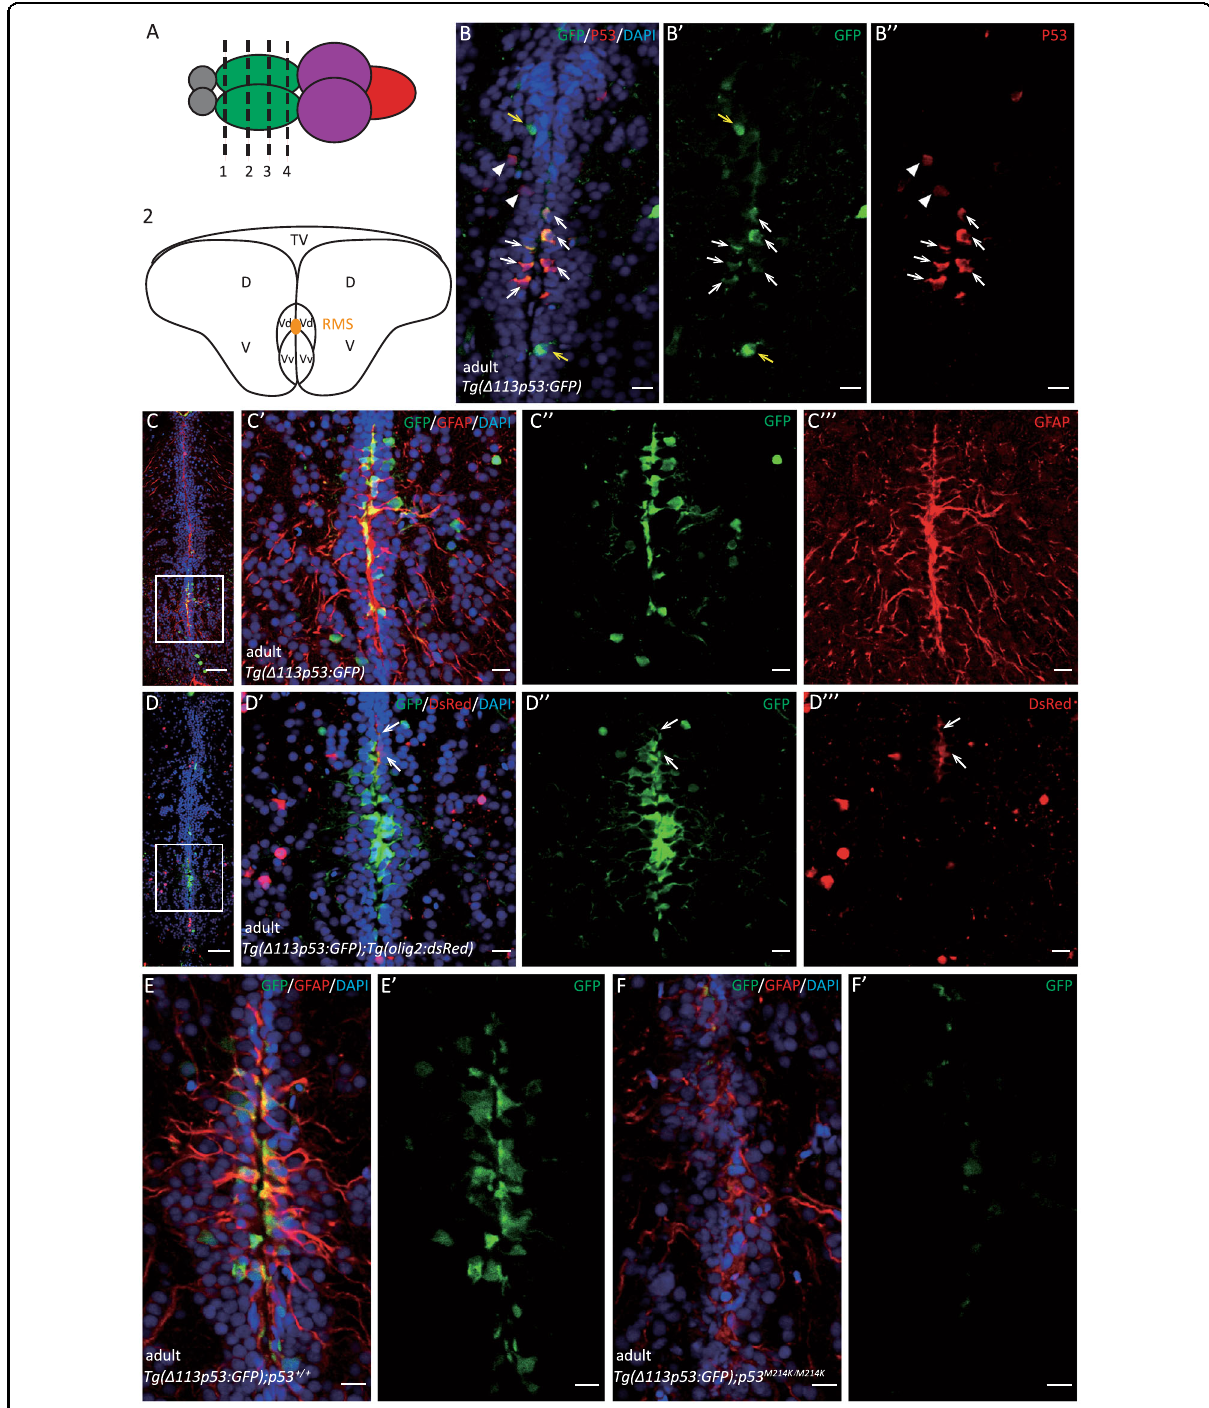
Fig. 1 (See legend on next